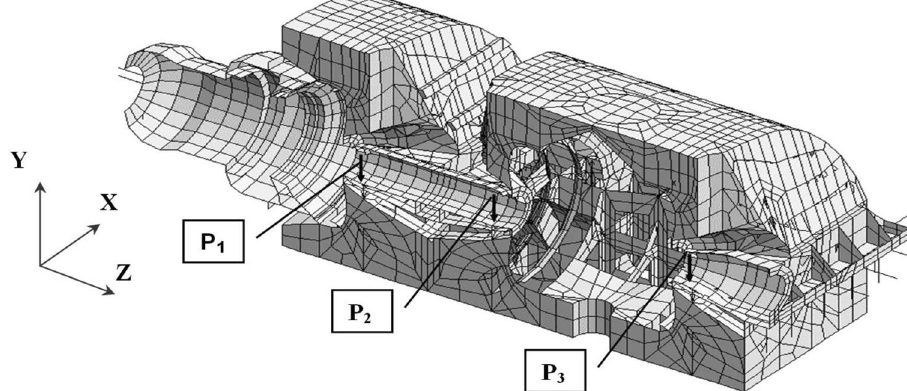
Table 1 Parameters of the computational models